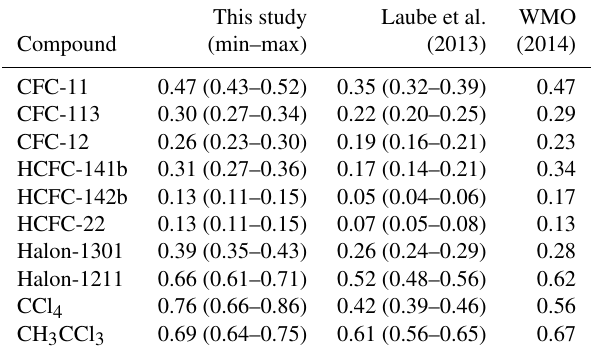
Table 6. Updated mid-latitude FRFs based on our “best-estimate” mean ages (taken at 3 years) derived in this study compared to ex- isting literature